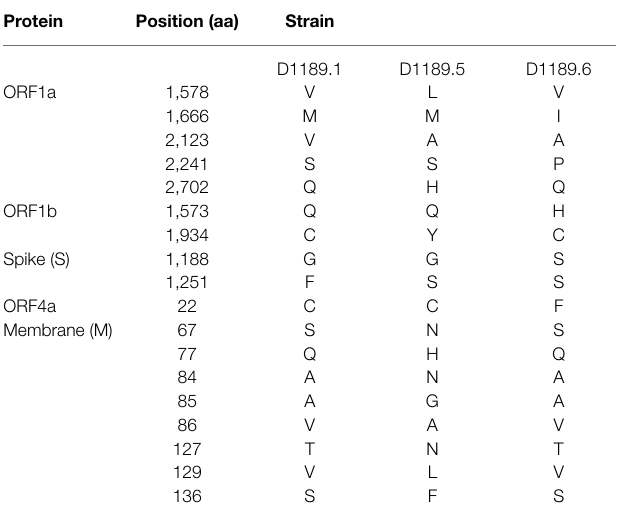
TABLE 1 | Comparison of amino acid substitutions among the three DcMERS- CoV isolates in this study. Protein Position